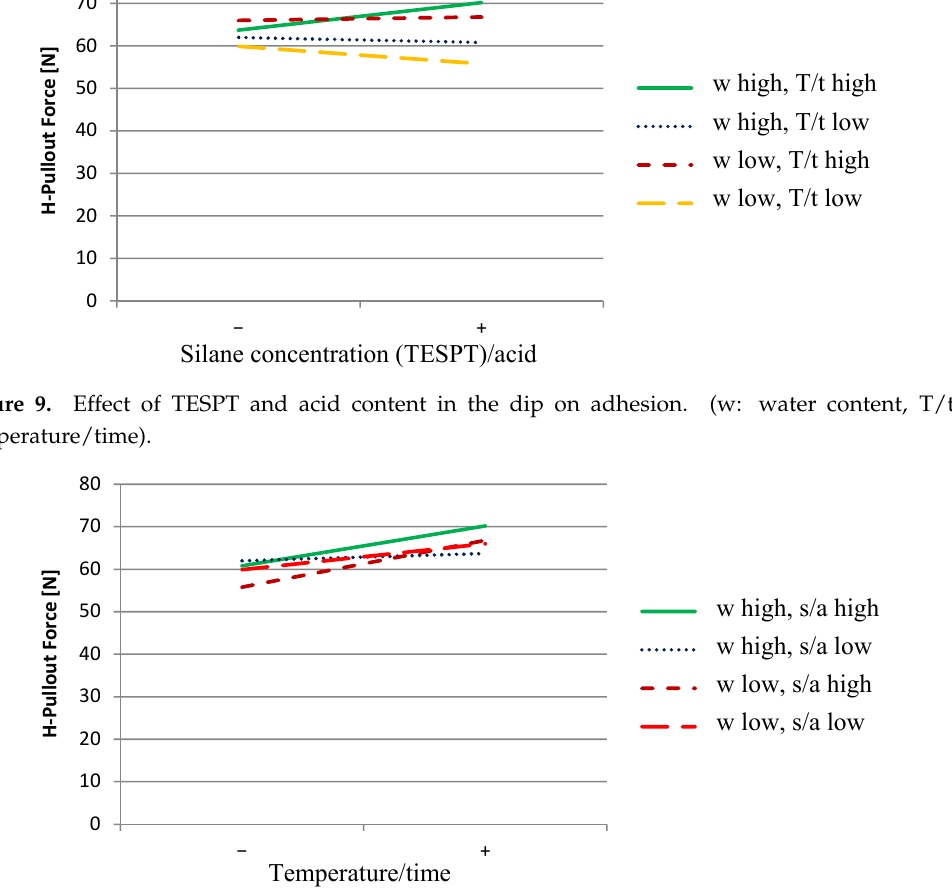
Figure 10. Effect of temperature and time on adhesion. (w: water content, s/a: silane (TESPT)/acid).